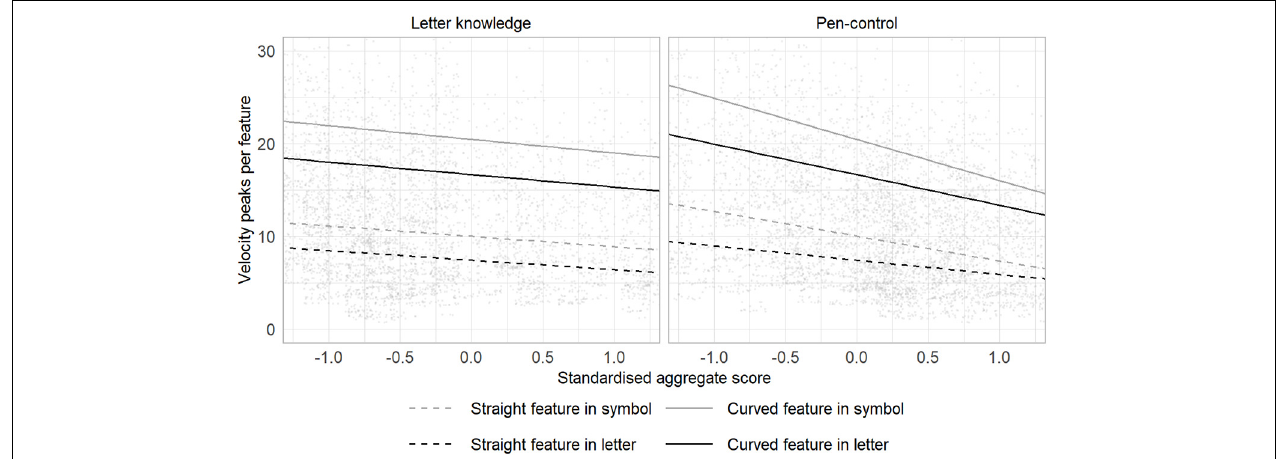
FIGURE 4 | Letter knowledge and pen-control measures as predictors of letters and symbols copying fluency (velocity peaks). Parameter estimates from best-fit model. X-axis values are for just those measures showing statistically significant effect: Letter knowledge is standardised phoneme-to-grapheme encoding score. Pen-control is the reversed mean of standardised fluency measures for garlands and figure-eights. Points represent raw observations.